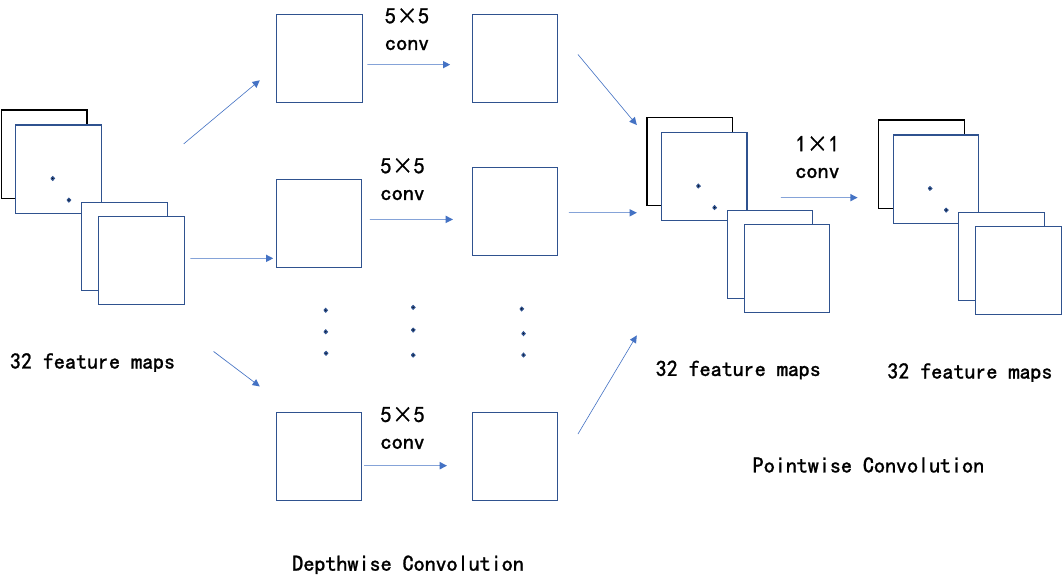
Figure 5 . Illustration of the depthwise convolution layer and the pointwise convolution